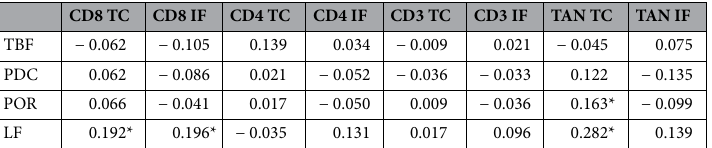
Table 7. Spearman’s rank correlation coefficients between selected tumor-infiltrating immune cells and tumor budding parameters and lymphoid follicles. Marked correlation coefficients are significant with p <